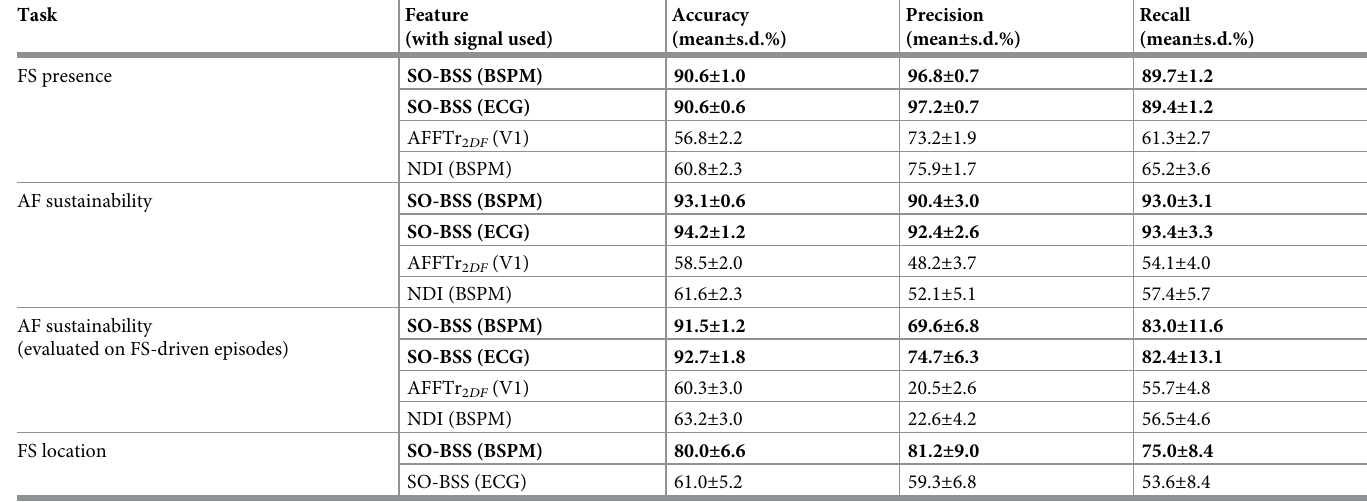
Table 2. Testing scores using nested leave-one-patient-out cross validation on all classification tasks over five patients, using features of SO-BSS, AFFTr 2 DF and NDI. Bold fonts mark the highest scores and the corresponding features. Task